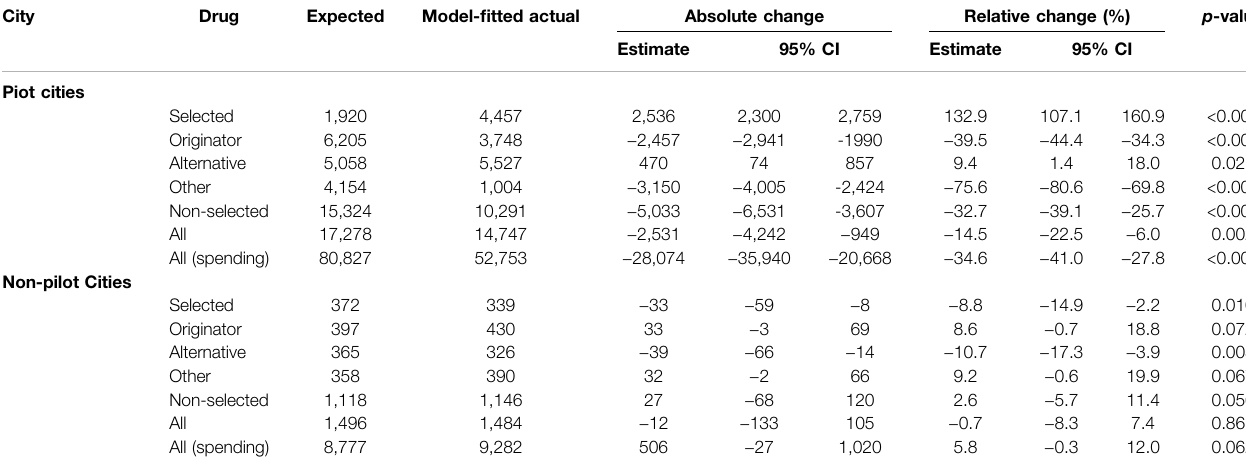
TABLE 2 | Overall changes in purchase strati fi ed by drug and intervention groups, March- September 2019. City Drug Expected